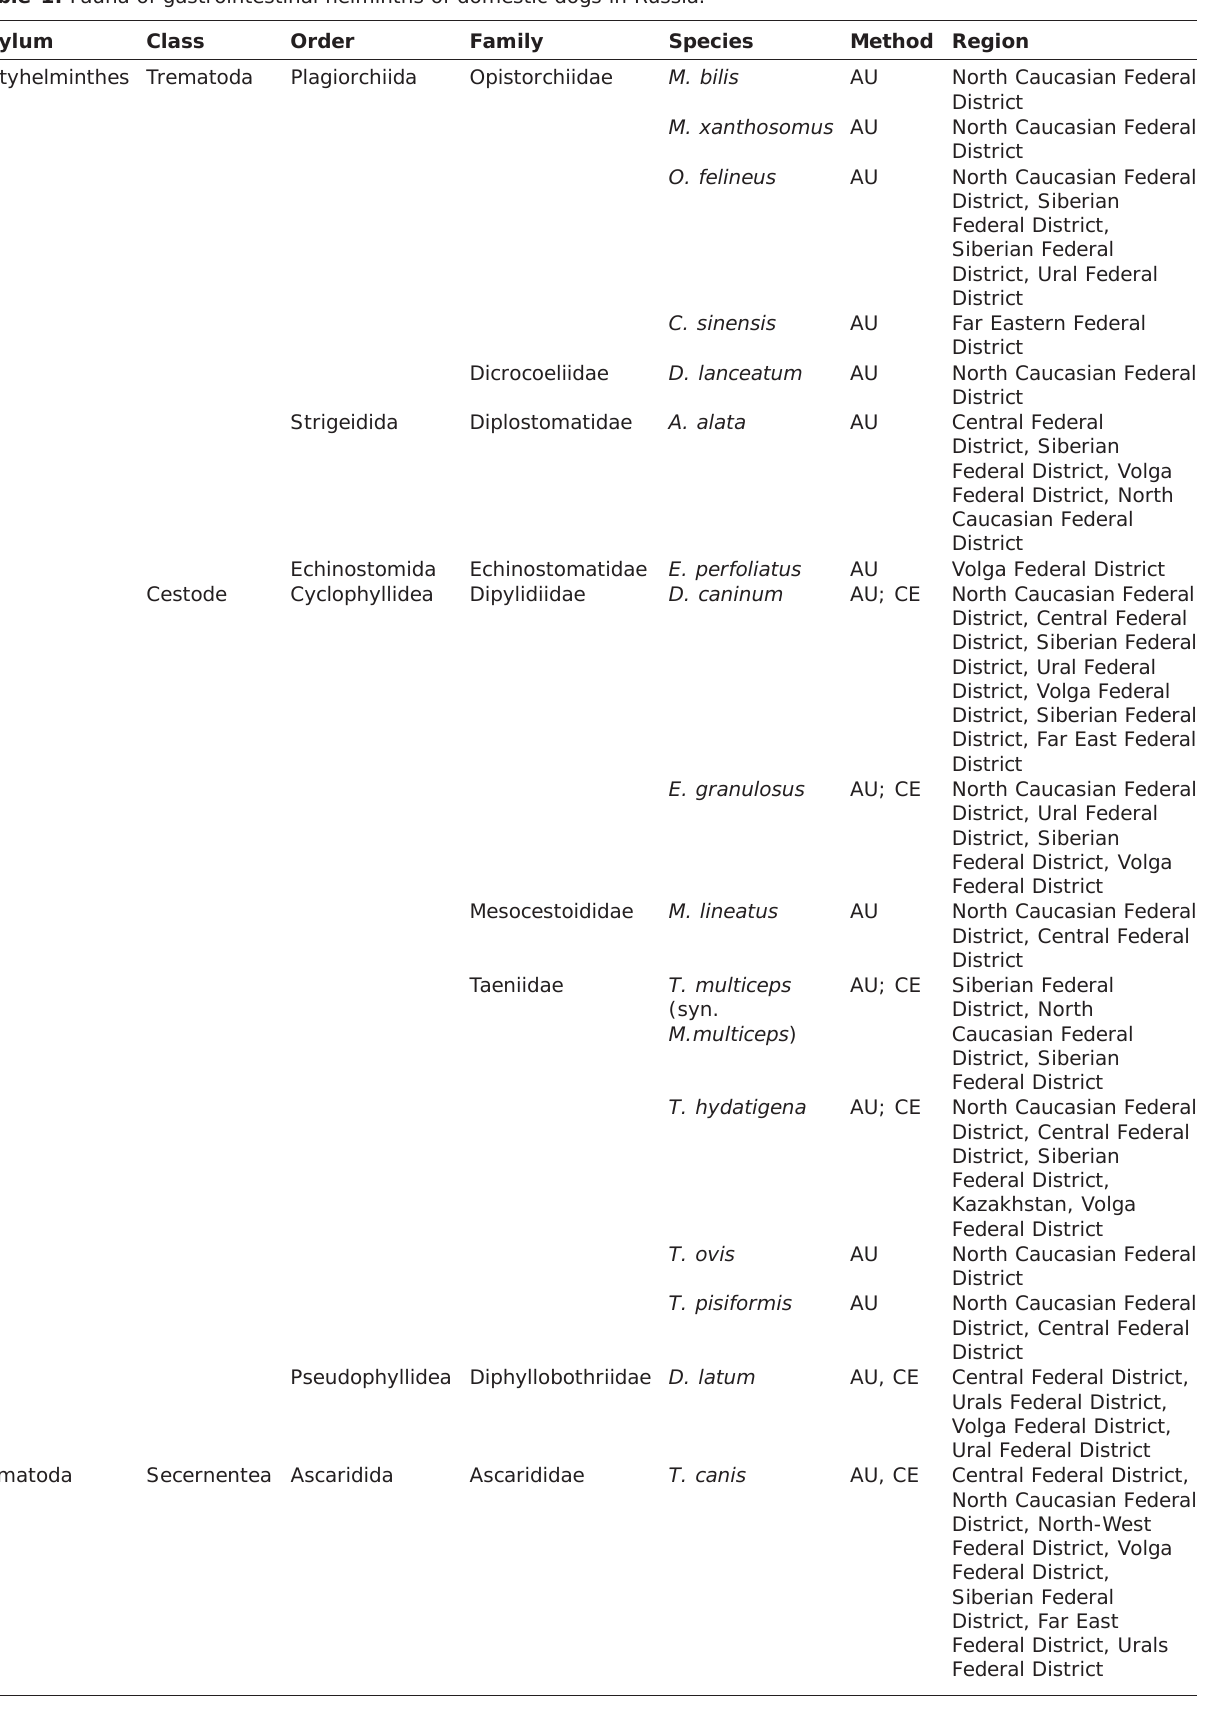
Table-1: Fauna of gastrointestinal helminths of domestic dogs in Russia.